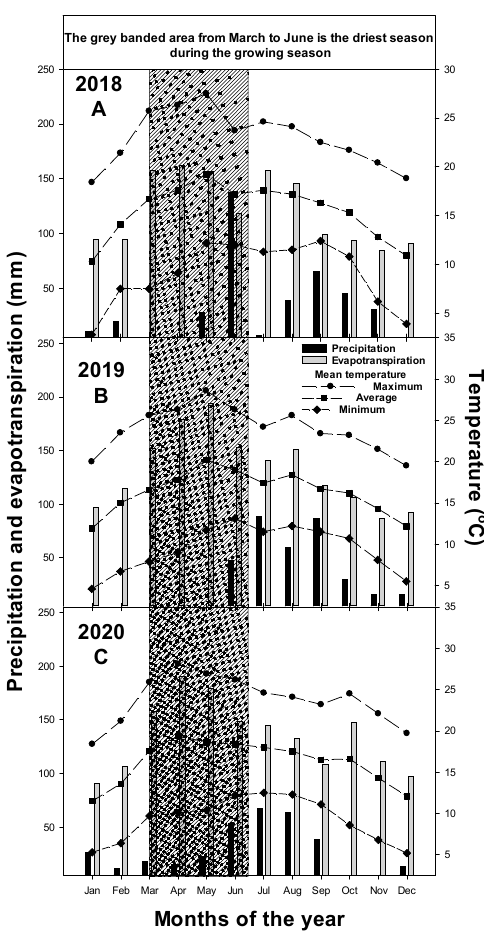
Figure 1. Climate conditions prevailed at the experimental site from 2018 to 2020. La Victoria, Pinos, Zacatecas, México.